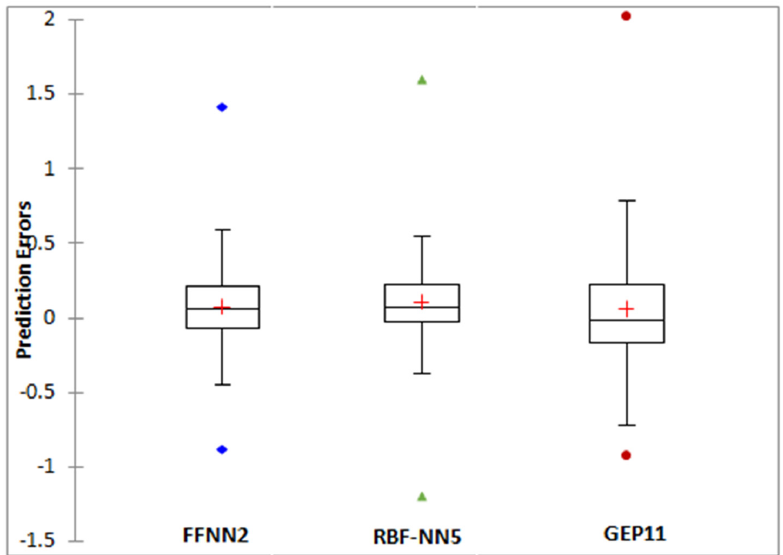
Figure 12. Box plot for best performing optimum number of input combination-based models. Table 13. Descriptive statistic of prediction errors for the optimum combination of inputs. The Taylor diagram of the observed and predicted ET 0 by different optimum input combination-based models over the test period is depicted in Figure 13. It is clear that the representative points of all the applied models have nearly the same position. The RBFNN11 model is located nearest to the observed point with the lower value of RMSE, SD, and higher value of the coefficient of correlation, making this model emerge as a superior model with the optimum number of input parameters.